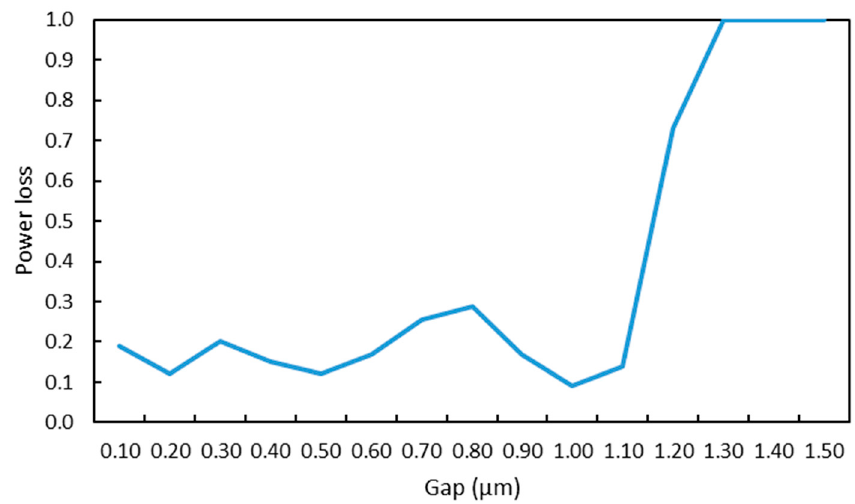
Figure 5. Power loss for various gaps between adjacent waveguides.